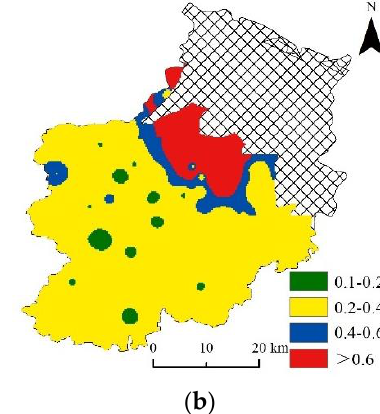
8 of 17 Table 4. Correlation coefficient matrix of soil salinity. Soil Depth (cm)